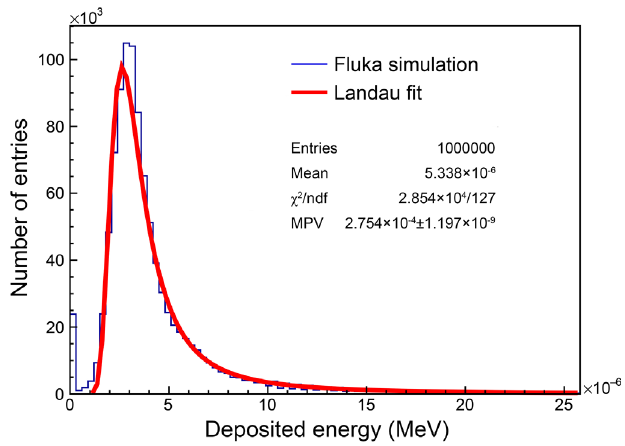
FIG. 7. Landau distribution of energy deposition for 1 GeV protons traversing the CSNS